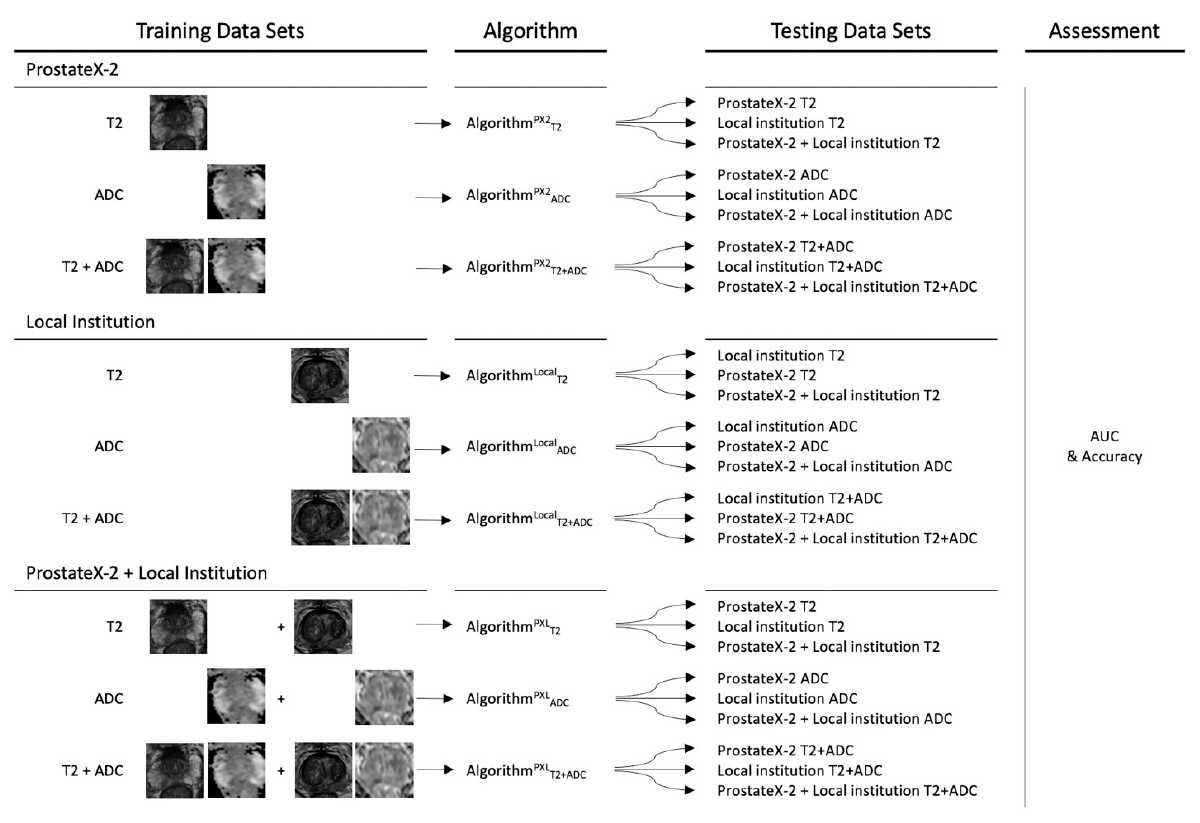
Figure 2. Schematic summarizing image datasets, algorithm training and testing. Table 2. Total patients included in each of the initial datasets trained and tested. The total included images for each imaging type (T2, ADC, or T2 + ADC) where the same imaging types were used for each training/testing combination for the model.